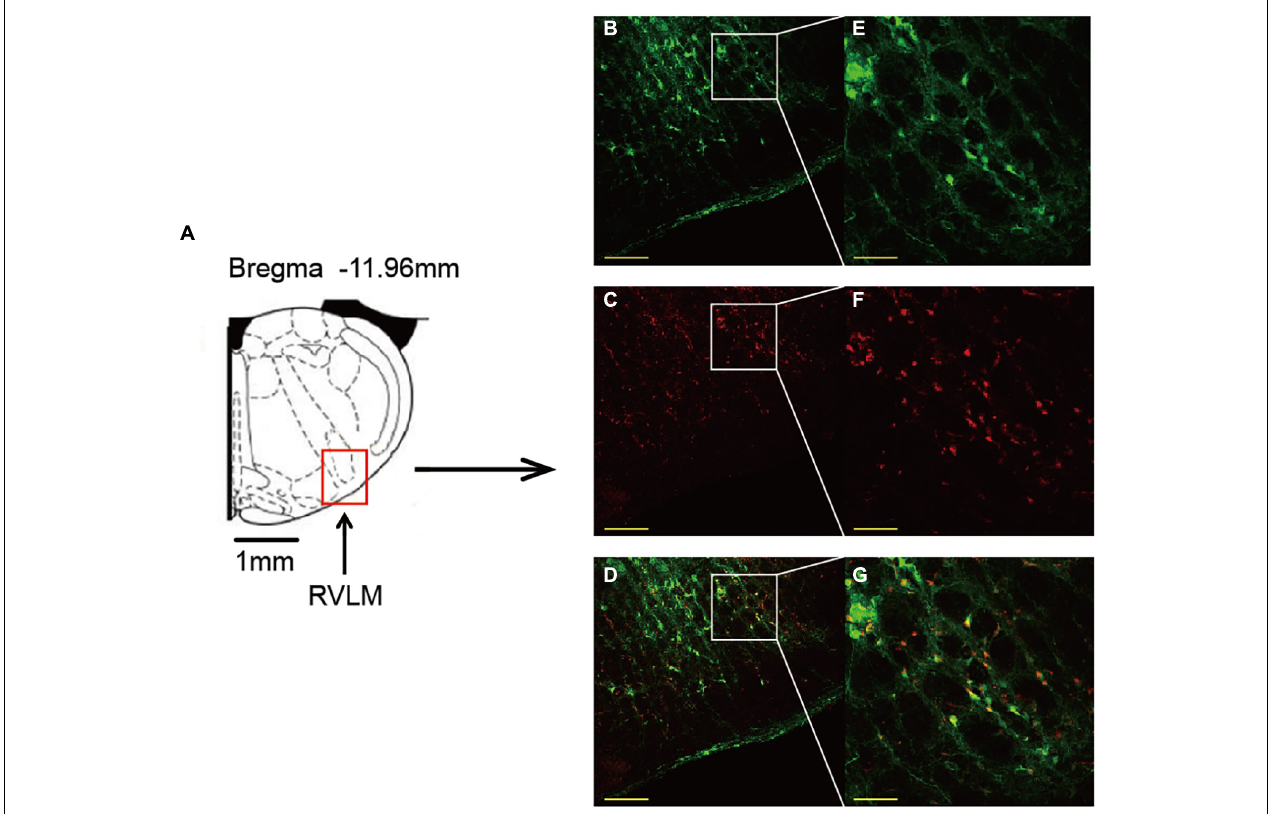
FIGURE 4 | Confirmation of the same injection site of both AAV and siRNA delivered in the RVLM. (A) Standard rat atlas of the RVLM region. (B,C) Green fluorescent protein (GFP) and Cy3 (red fluorescence) confirmed in the RVLM. (D) Merged image of (B,C) . (E–G) Enlarged images of (B–D) . Scale bars = 200 µ m in (B–D) and 50 µ m in (E–G) . AAV, adeno-associated virus; siRNA, small interfering RNA; RVLM, rostral ventrolateral